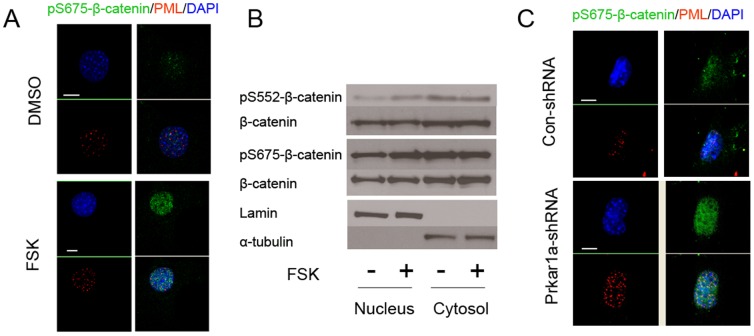
PKA activation promotes nuclear relocalization of phospho-β-catenin.A. Immunofluorescence for pS675-β-catenin (green), PML (red), with DAPI nuclear staining (blue) in MC3T3-E1 cells treated with vehicle (DMSO) or FSK. Note the nuclear accumulation of phospho-β-catenin in response to FSK. B. MC3T3-E1 cells were treated with vehicle or FSK and nuclear and cytosolic protein fractions prepared and blotted for the proteins shown. Specificity of the fractionation is demonstrated by blotting for Lamin A (nuclear marker) and α-tubulin (cytosolic marker). Note the enhanced phospho-β-catenin only in the nuclear fraction in response to FSK. 8 µg of nuclear and 20 µg of cytosolic protein were loaded per lane. C. Control or Prkar1a-knockdown MC3T3-E1 cells were studied by IF as in panel A. Scale bar for all images: 10 µm.